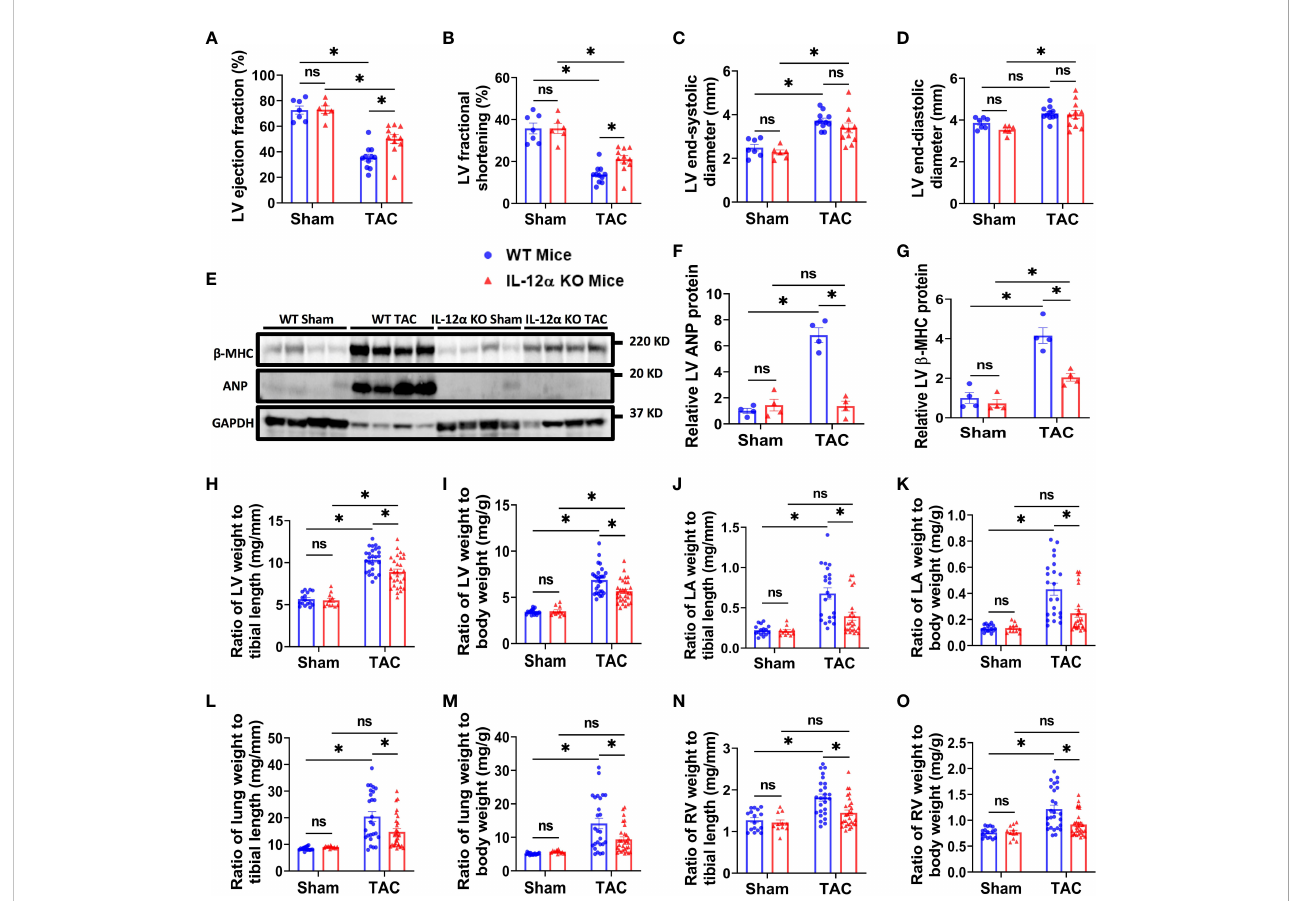
FIGURE 1 IL-12 a KO ameliorated TAC-induced LV failure, LV hypertrophy, increase of lung weight, and RV hypertrophy in male mice. (A – D) Quanti fi ed data of echocardiographic measurements of LV ejection fraction, LV fractional shortening, LV end-systolic diameter, and LV end-diastolic diameter. (E – G) LV b - MHC and ANP expression in corresponding groups. (H – O) The ratio of LV weight, LA weight, lung weight, RV weight to tibial length or body weight in corresponding mice. *p<0.05; ns, non-signi fi